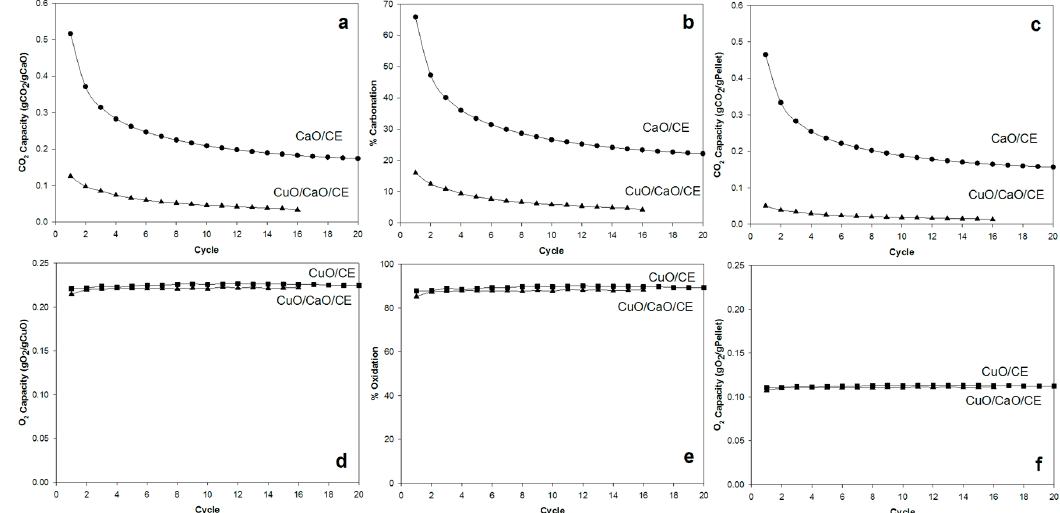
Figure 3. Performance of CaO/CuO/CE, CuO/CE, and CaO/CE pellets over multiple cycles in terms of ( a ) CO 2 capacity per gram of CaO; ( b ) % Carbonation; ( c ) CO 2 capacity per gram of pellets; ( d ) O 2 capacity per gram of CuO; ( e ) % Oxidation; and ( f ) O 2 capacity per gram of pellets.